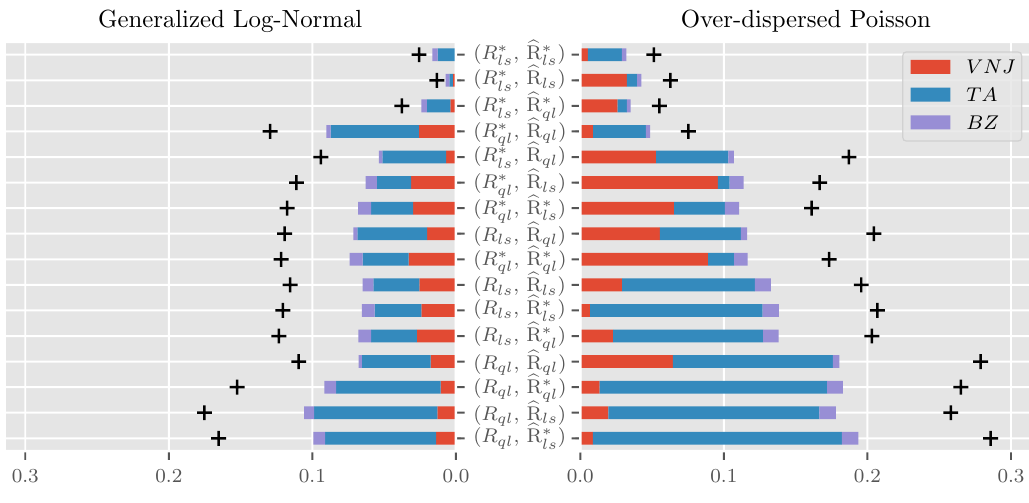
Figure 2. Bar chart of the area under the curve of absolute approximation errors (also roughly mean R. Ordered by the sum of errors within the absolute error) for the considered combinations of R and combination across the data generating processes and parameterizations increasing from top to bottom. (cid:98) Sum of maximum absolute errors across parameterizations indicated by “ + ”. VNJ , TA and BZ are short for parameters set to their estimates from the Verrall et al. (2010) data in Table 1, the Taylor and Ashe (1983) data in Table A2 and the Barnett and Zehnwirth (2000) data in Table A1, respectively. Based on 10 5 repetitions for each parametrization. s =